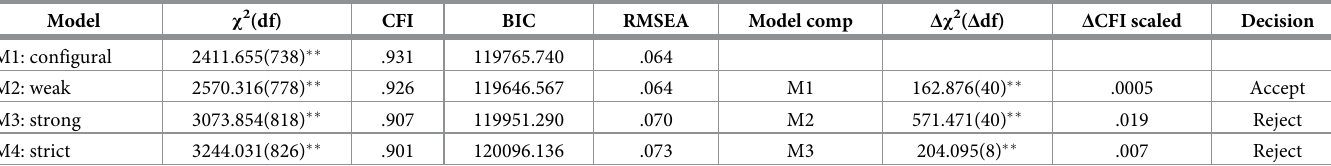
Table 6. Measurement invariance.